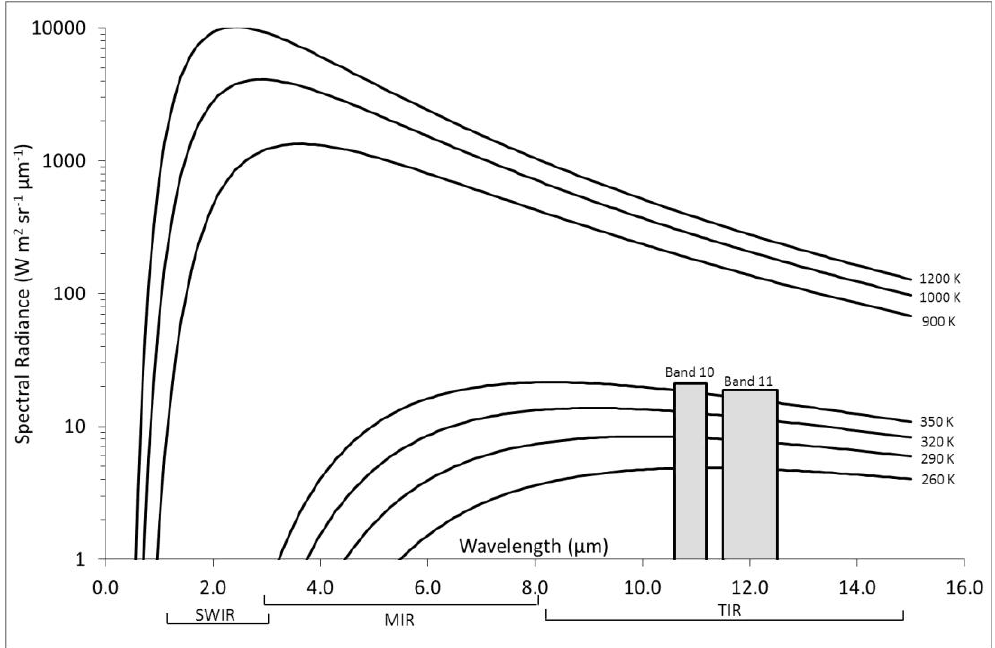
Figure 2. The spectral range of sensitivity within which the TIRS bands (Landsat-8 bands 10 and 11) operate, overlain on the Planck Function displaying the temperature range these bands are capable of detecting and, for comparison, the infrared emissions from surfaces at a range of